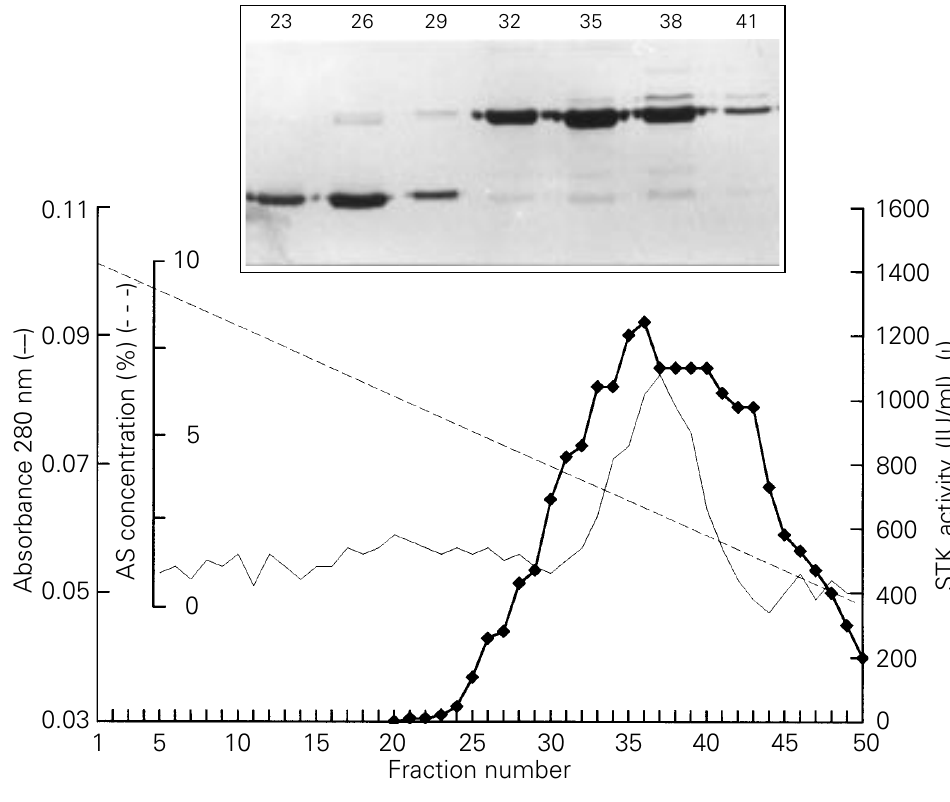
Figure 2 - Elution profile of rSTK produced in E. coli by phenyl- agarose column chromatogra- phy. The periplasmic protein fraction with streptokinase (STK) activity eluted from the DEAE Sepharose column was applied to a phenyl-agarose col- umn equilibrated with 20 mM phosphate, and 10% ammo- nium sulfate, pH 7.0. Adsorbed proteins were eluted with a lin- ear gradient of 10%-0% ammo- nium sulfate (AS) concentration in equilibration buffer. The frac- tion size was 1.3 ml per tube. Full line, Absorbance at 280 nm; squares, STK activity; broken line, ammonium sulfate concen- tration. Inset: Western blot a- nalysis with an anti-STK poly- clonal antiserum of selected fractions eluted from the phe- nyl-agarose column, showing the rSTK forms in each